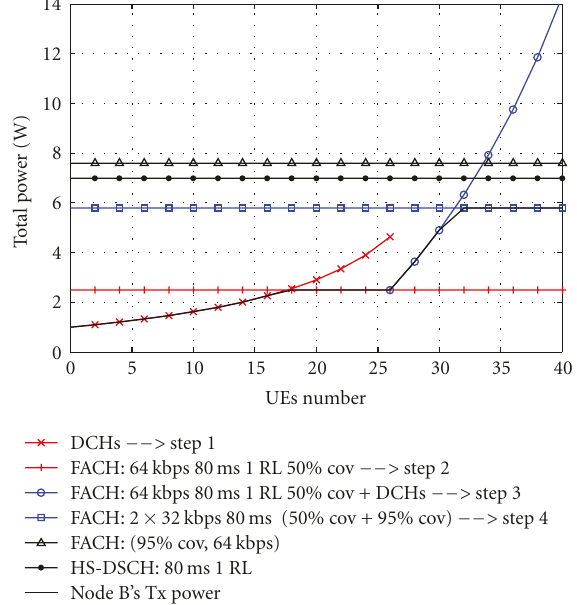
Figure 14: Node B’s Tx power with combination of techniques 4.4, 4.5, and 4.6.